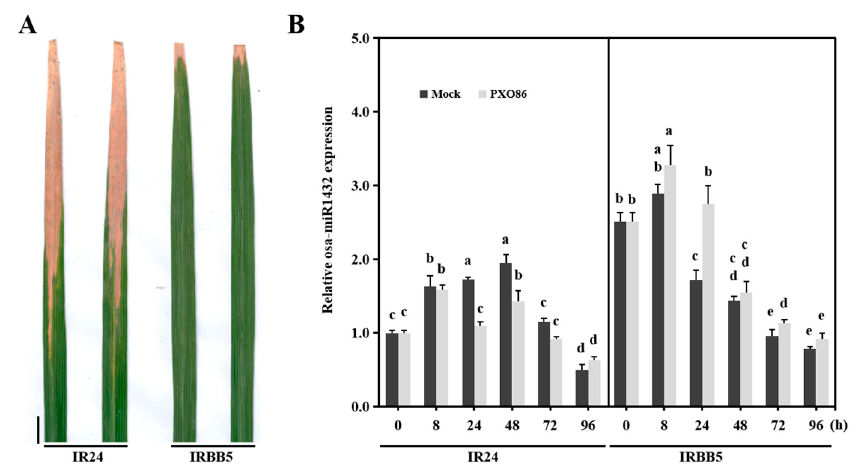
Figure 1. Differential expression patterns of osa-miR1432 in susceptible and resistant genotypes upon Xoo infection. ( A ) Phenotype of representative leaf sections from susceptible genotype IR24 and resistant genotype IRBB5 at 20 dpi with Xoo strain PXO86. ( B ) Accumulation of osa-miR1432 was monitored using RT-qPCR in susceptible and resistant genotypes under Xoo strain PXO86 and mock treatment. Scale bar, 2 cm. Error bars indicate standard deviation ( n = 3). Different letters above the bars indicate significant differences ( p < 0.01) determined by one-way analysis of variance (ANOVA) followed by post hoc Tukey HSD analysis.